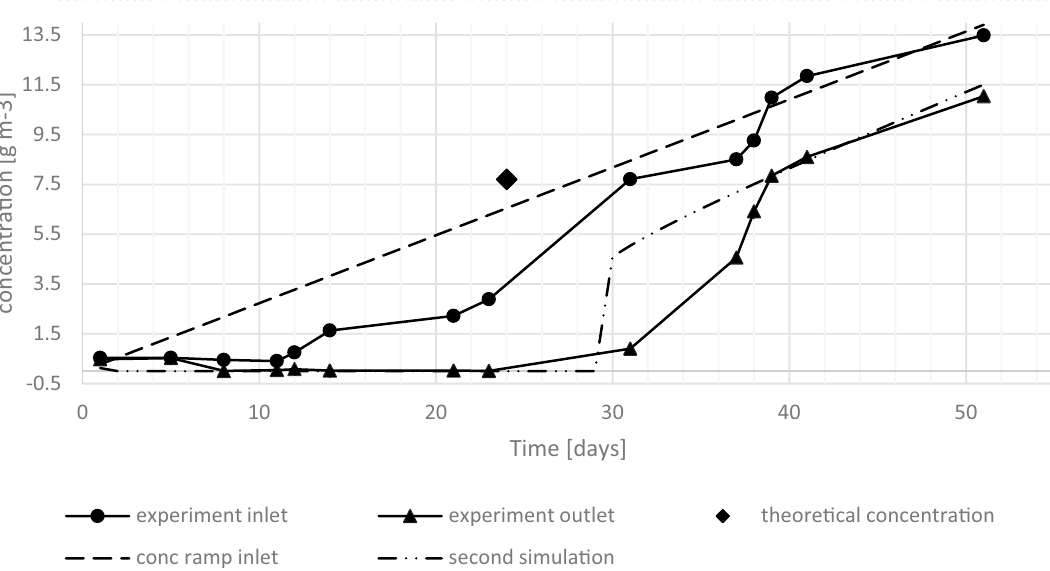
Figure 3. Experimental results and predicted outlet concentration at steady increasing of inlet concentration at steady increase of inlet